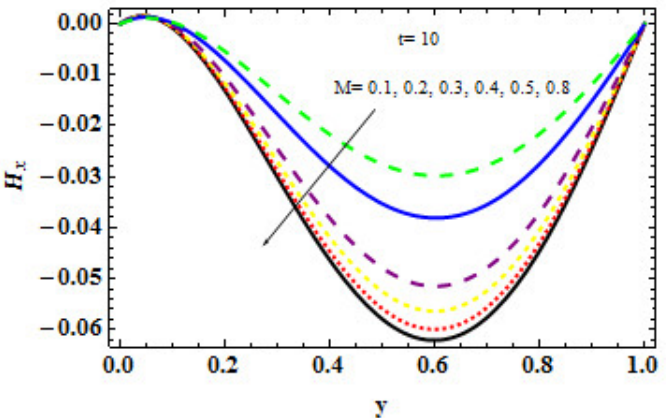
Figure 14. M effect on the IMF with respect to time.